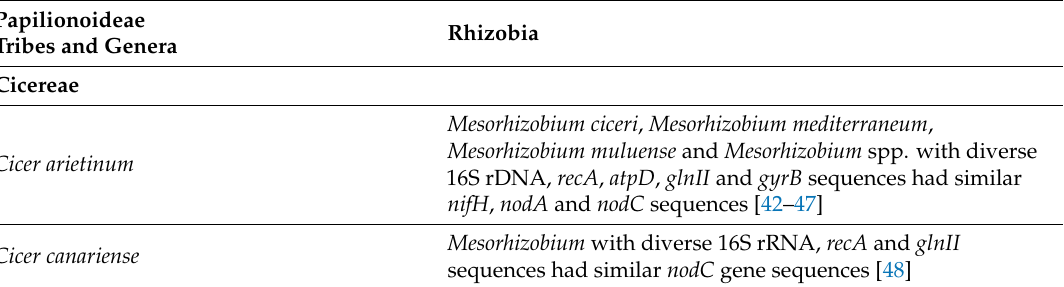
Table 2. Reported cases of phylogenetic incongruence between core and symbiosis genes for rhizobia associated with legumes in the inverted repeat-lacking clade (IRLC) of the legume sub-family Papilionoideae. All species have indeterminate